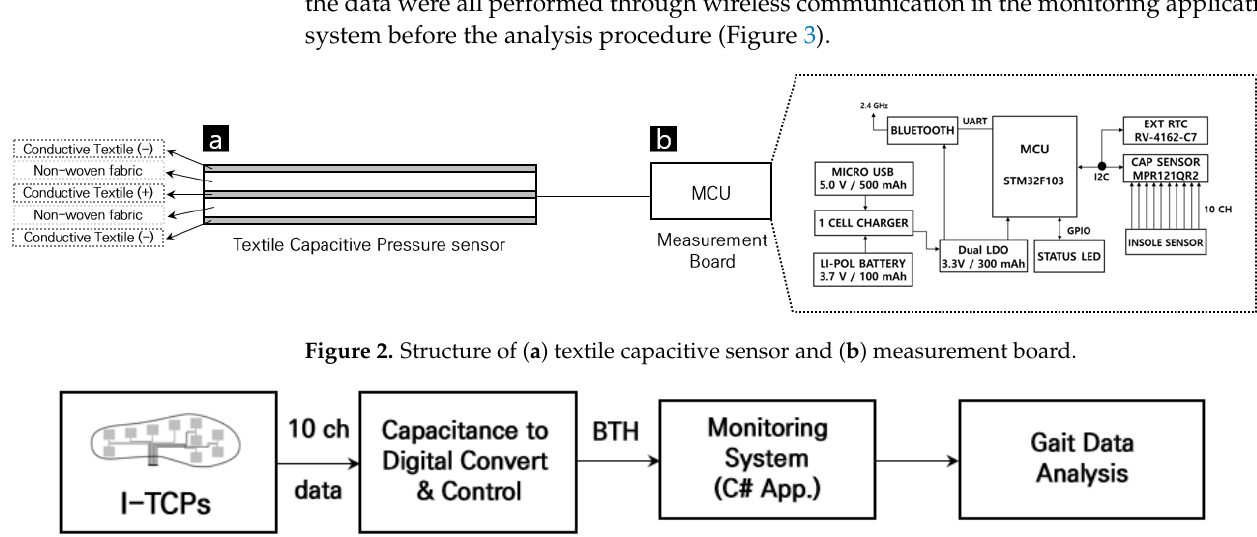
Figure 1. Design of insole-type textile capacitive sensors (I-TCPs).